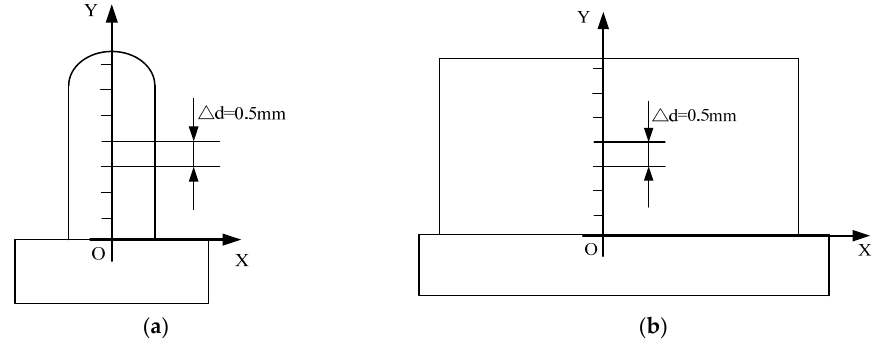
Figure 5. Micro hardness measurements of ( a ) thin wall samples and ( b ) block samples.